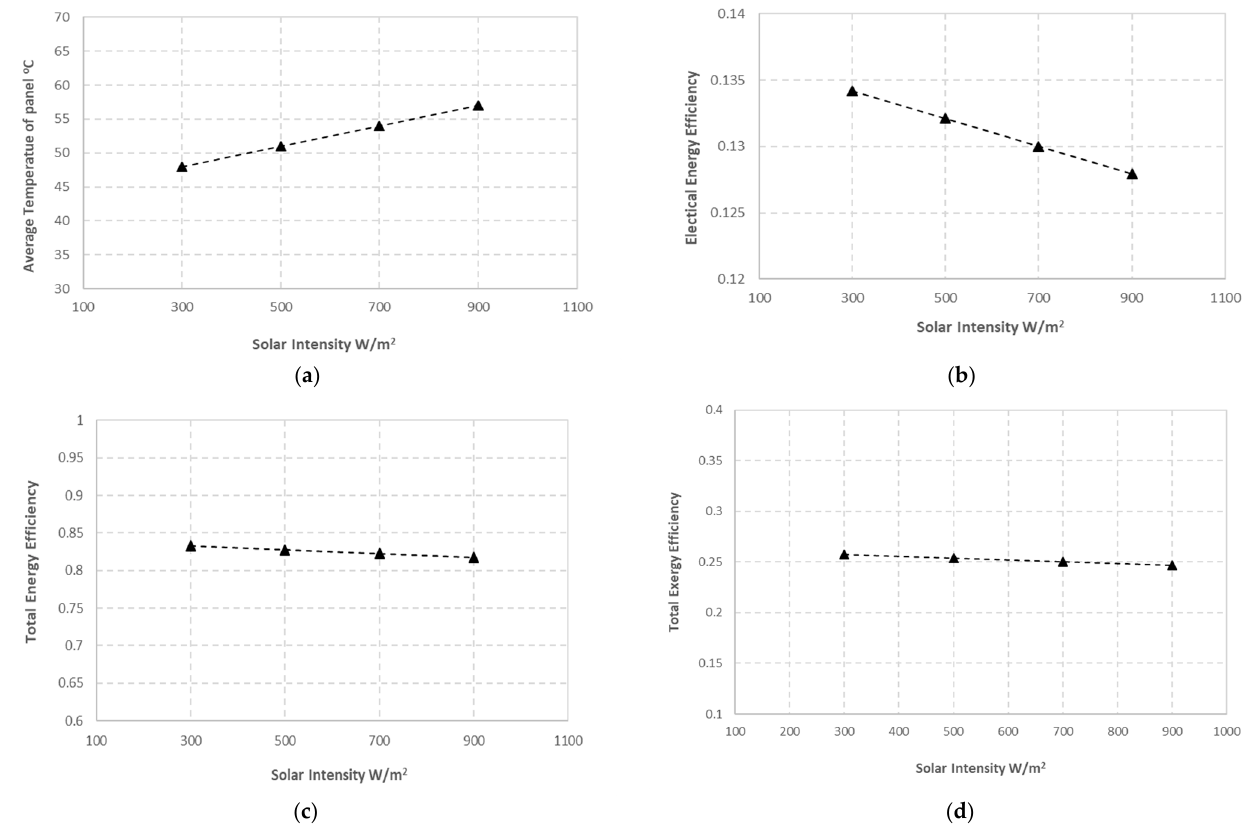
Figure 20. The in fl uence of solar intensity on ( a ) average temperature of panel ( b )electrical energy Figure 20. The influence of solar intensity on ( a ) average temperature of panel ( b ) electrical energy e ffi ciency (c) total energy e ffi ciency ( d ) total exergy e ffi ciency. efficiency ( c ) total energy efficiency ( d ) total exergy